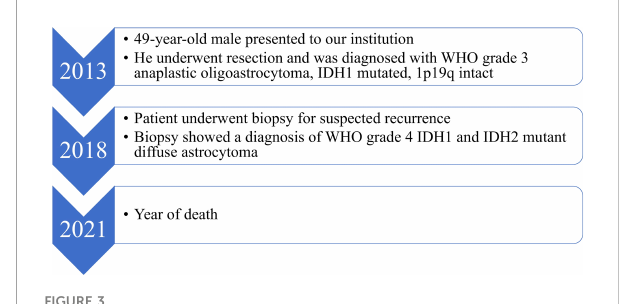
FIGURE 3 Patient care timeline from presentation to our institution until